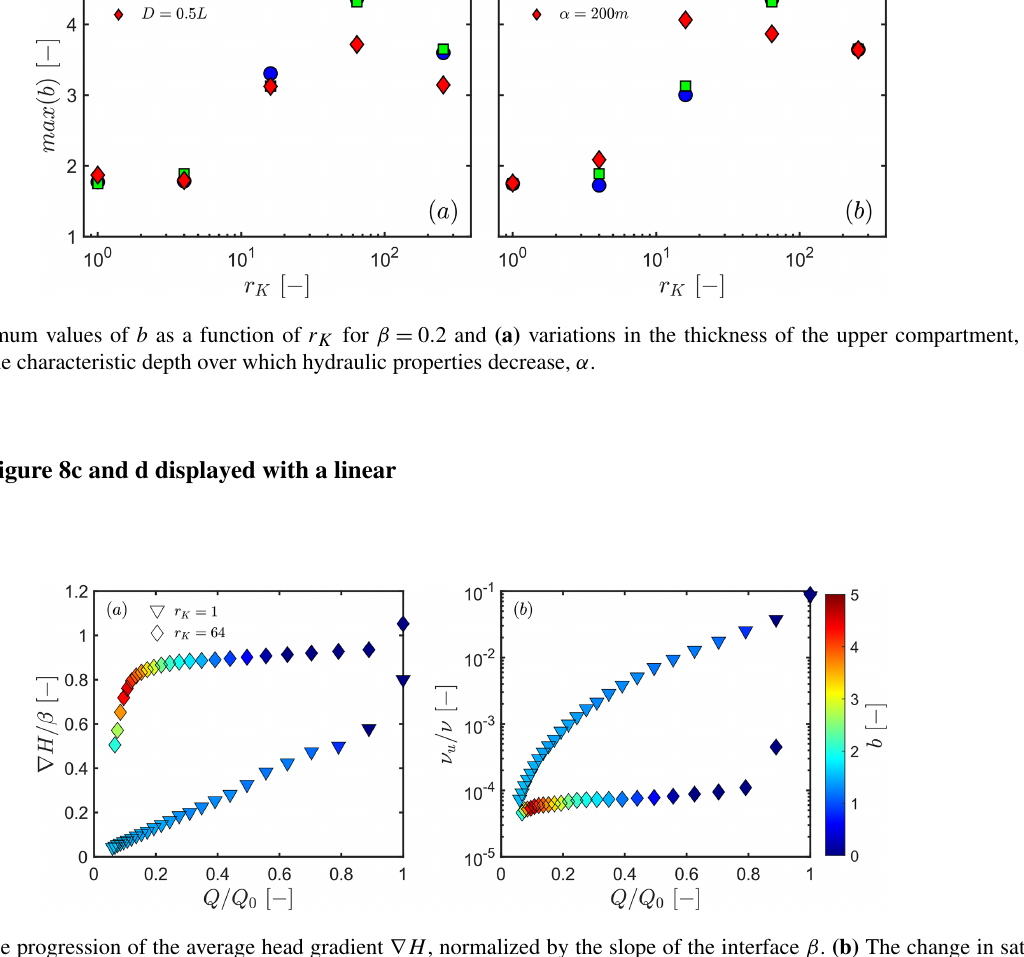
Code and data availability.